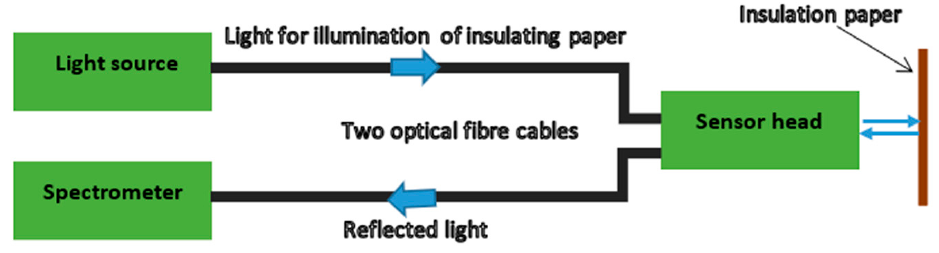
Figure 6. Insulation paper optical reflection spectroscopy principle.